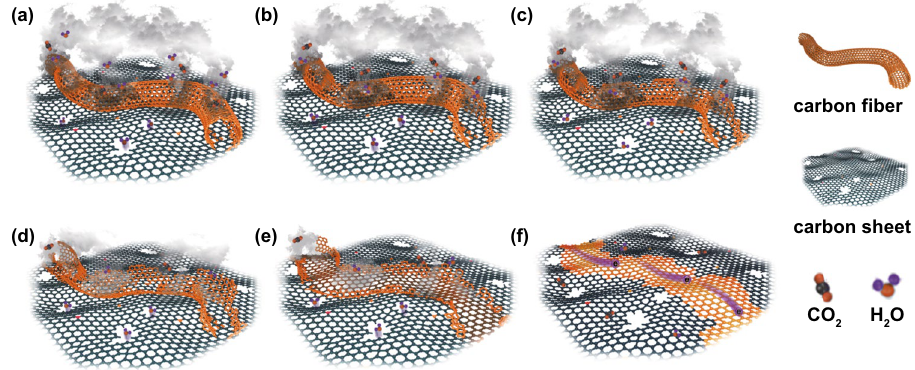
Fig. 4 Schematic illustration of the transformation of GCs from heterogeneous structures (e.g., nanofiber and nanosheet) to nanosheet